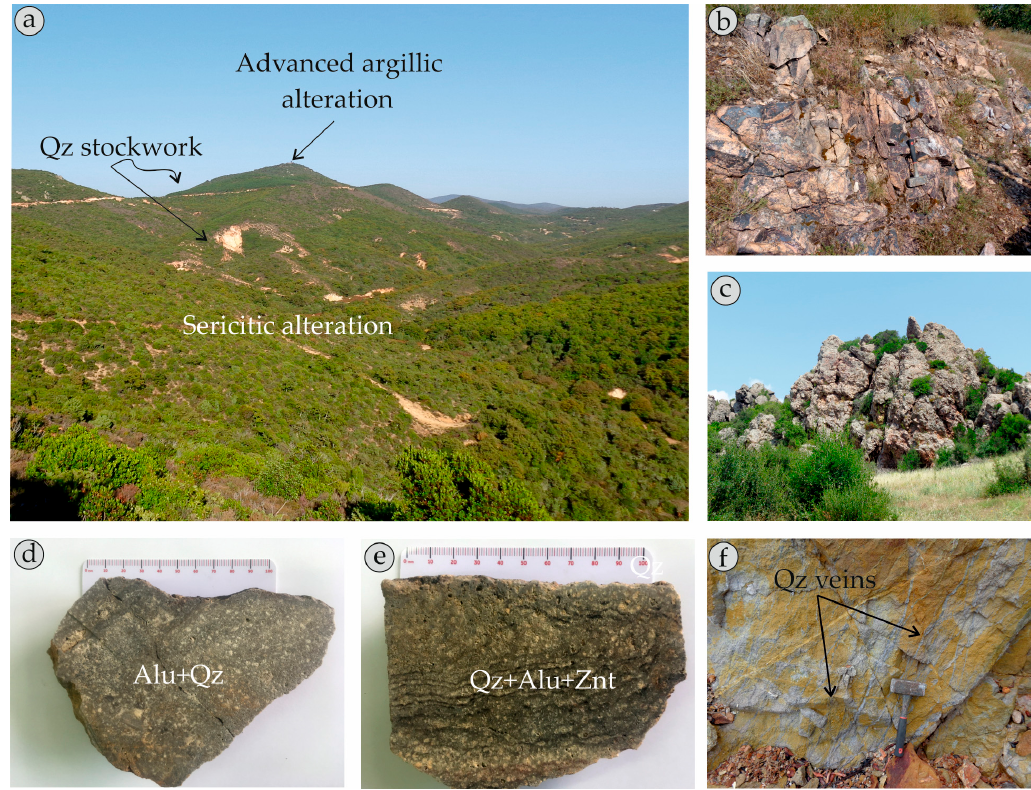
Figure 3. Field and hand-specimen photographs from Konos Hill, NE Greece. ( a ) Panoramic view of Konos Hill; ( b ) Quartz–alunite–zunyite-bearing rocks on top of Konos Hill; ( c ) Quartz–alunite–diaspore-bearing rocks in the NW slopes of Konos Hill; ( d , e ) Hand-specimens of quartz–alunite (Alu + Qz) and quartz–alunite–zunyite (Qz + Alu + Znt) assemblages; ( f ) Quartz porphyry stockwork veins in sericitic-altered granodiorite from Saporema Creek.